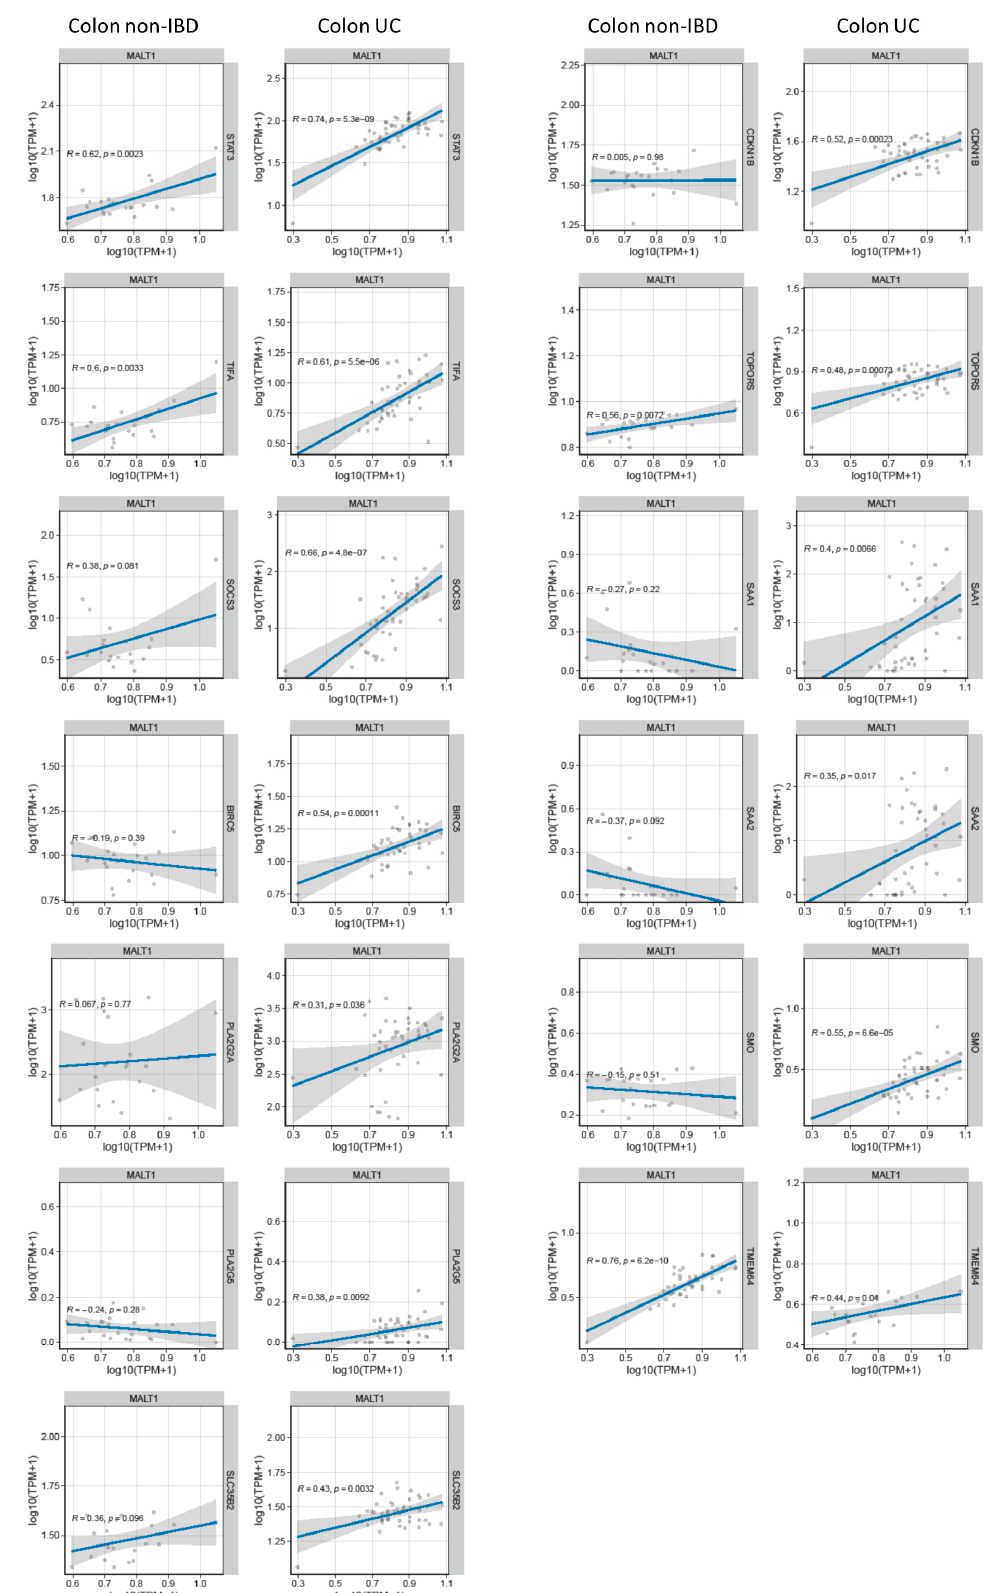
Figure 7. MALT1 gene expression levels correlate with wound healing associated gene expression in UC. RNA-seq correlation analysis of MALT1 and STAT3-regulated wound healing associated genes.